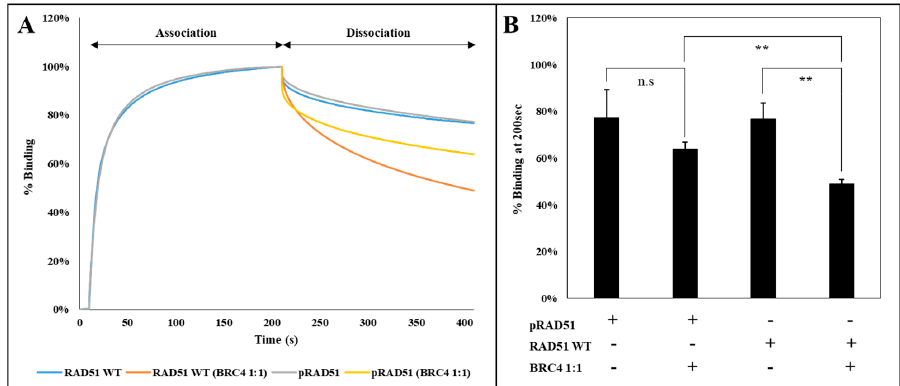
8 of 18 Figure 6. c-MET-mediated RAD51 phosphorylation promotes the formation of high-molecular- weight RAD51 oligomers. ( A ) The RAD51 WT protein (10 µM) was purified and incubated with ATP (2 mM) and with or without kinase-active c-MET (0.1 µM) and PHA665752 inhibitor (1 µM). Then, the proteins were crosslinked with BS3, separated by SDS-PAGE 10% gel and analyzed by western blot using anti-RAD51 antibodies. The signals were quantified by Odyssey scanner. ( B ) The graph represents the average of the ratios of the polymer forms of RAD51 phosphorylated or not by c-MET. The ratios were obtained after quantification of the blots from three independent experiments ( n = 3; error bars: s.d.; ** p < 0.01).